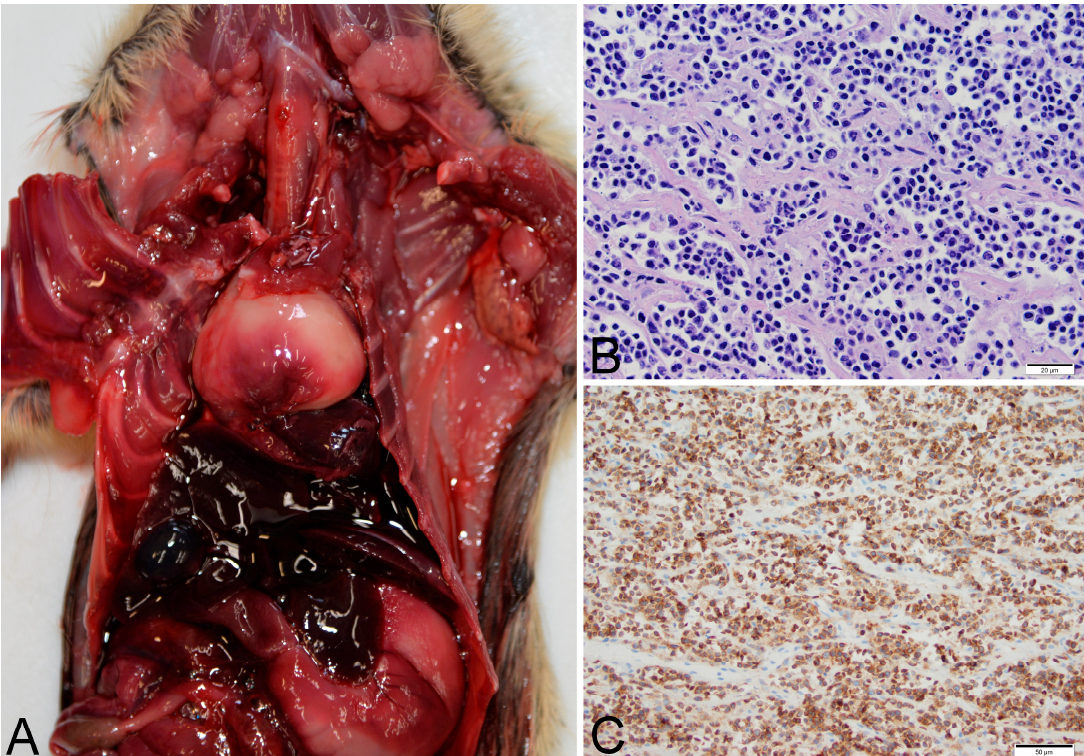
Figure1. ThymiclymphomaidentifiedinaGunnison’sprairiedog(Case14-1342). ( A )Anapproximately 3 cm diameter, soft, white mass displaces the heart caudally. ( B ) Histologic findings included uniform infiltrates of neoplastic lymphocytes (hematoxylin and eosin). ( C ) Immunohistochemical staining with anti-CD3 identified neoplastic cells as